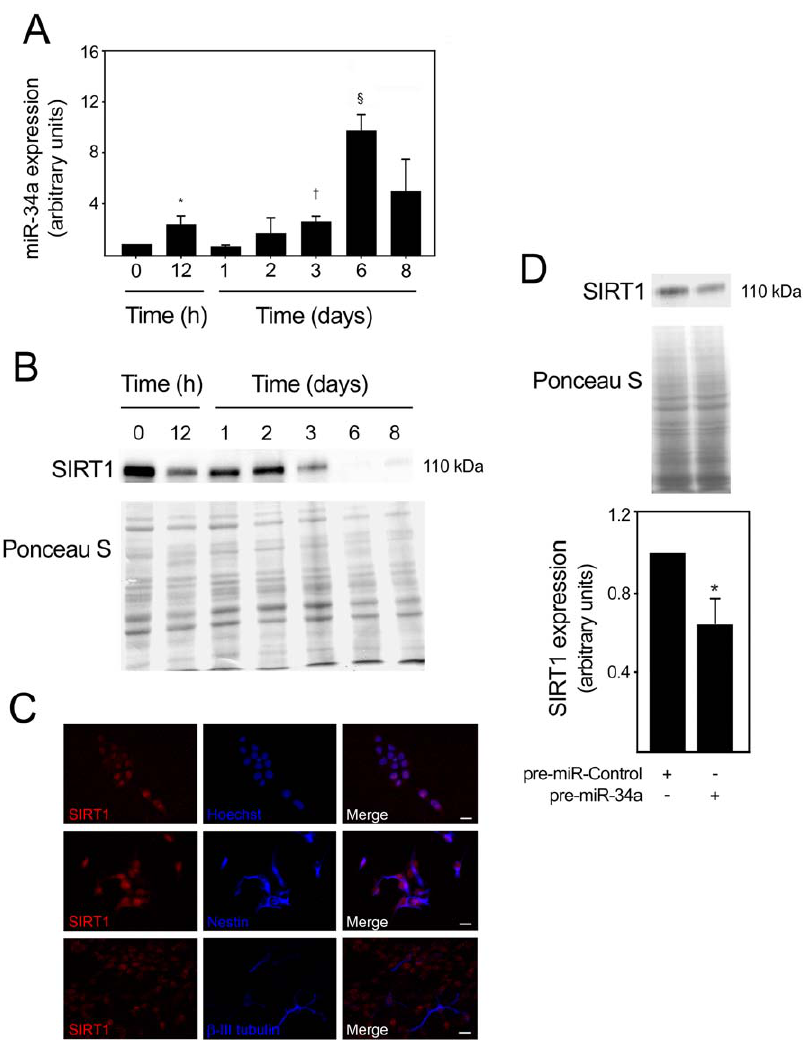
Figure 2. SIRT1 expression levels decrease after miR-34a overexpression. miR-34a expression was analyzed by quantitative Real Time-PCR using specific Taqman primers and GAPDH for normalization. Expression levels were calculated by the DD Ct method using undifferentiated cells as calibrator. SIRT1 expression in mouse NS cells was detected by immunoblotting at different times of differentiation or by immunocytochemistry at 2 days of differentiation. Cells transfected with either control or pre-miR-34a at 3 days of differentiation were also processed for SIRT1 detection by immunoblotting. A. Expression of miR-34a throughout the differentiation period. * p , 0.05, { p , 0.01 and 1 p , 0.001 compared to day 0 (undifferentiated cells). Data represent mean 6 SEM of four independent experiments. B. Representative immunoblot showing a marked decrease in SIRT1 expression levels from day 3 of differentiation. Ponceau S was used as loading control. C. Immunofluorescence detection of cells labeled with anti-SIRT1, anti-Nestin and anti- b -III tubulin antibodies to visualize nuclear SIRT1 expression in neural progenitors and neuronal precursors, respectively. Hoechst 33258 staining was used to visualize cell nuclei. Scale bar, 10 m m. D. Representative immunoblot ( top ) and corresponding densitometry analysis ( bottom ) showing decreased SIRT1 expression in pre-miR-34a transfected cells. Data represent mean 6 SEM of three independent experiments. * p , 0.05 from cells transfected with control.